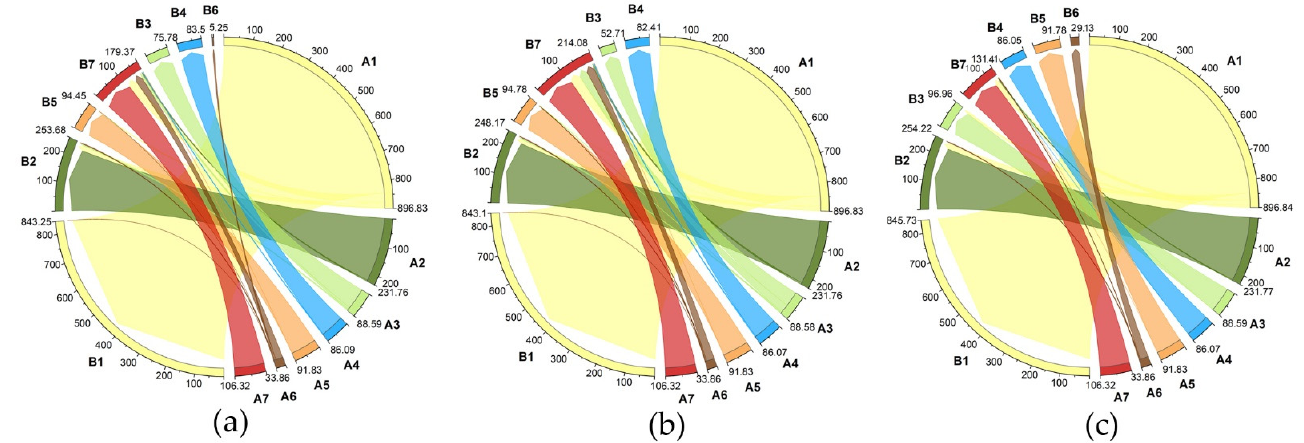
Figure 7. Land use conversion area chord diagrams. ( a ) NGS; ( b ) EDS; and ( c ) EPS. A1–A7 are the land use types in 2020; B1–B7 are the land use types in 2030; 1–7 represent cultivated land, woodland, grassland, waters, rural settlements, unused land, and urban and other construction land.